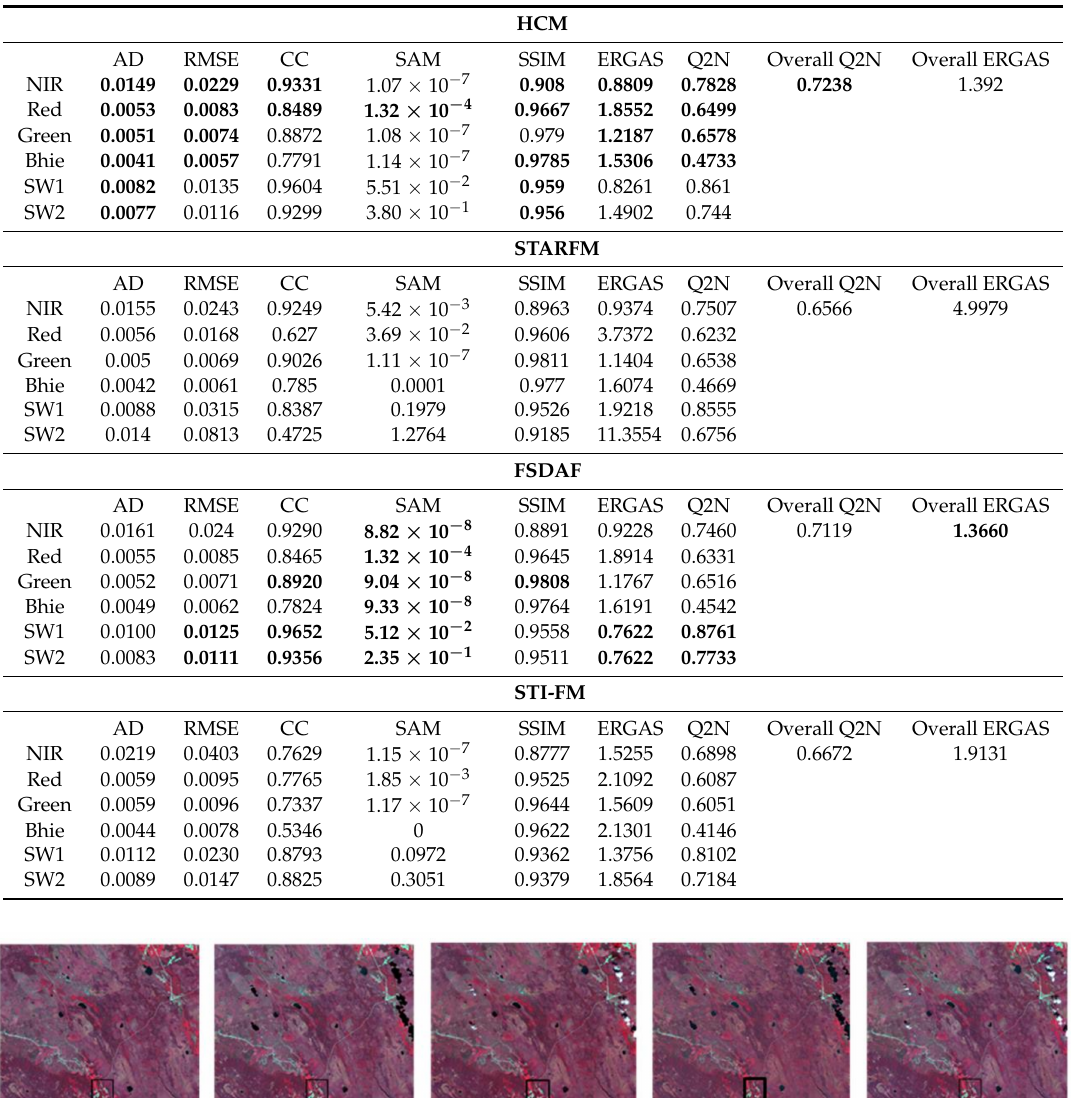
Table 3. Comparison of forward prediction results of using Landsat image 144 to predict Landsat image 192.